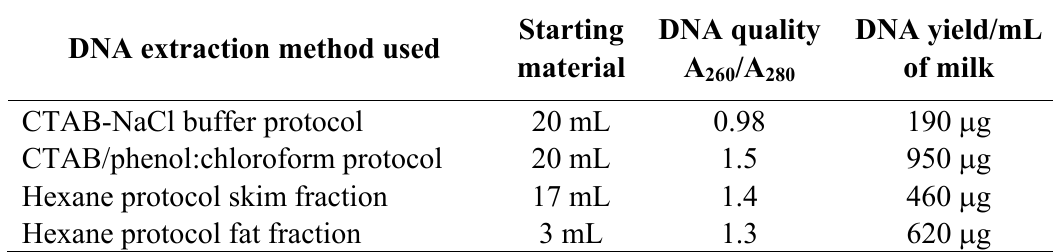
Table 1. Comparison of three different DNA extraction protocols performed on the same brand-labeled raw cow milk sample. The quality of total DNA is expressed by the /A ratio value. The total DNA yield is calculated per mL of extracted milk sample or A 260 280 fraction of it and represents the average of at least two different DNA